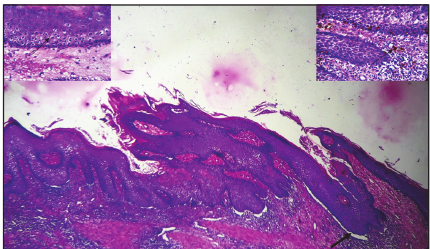
Figure 4: Photomicrograph showing parakeratinised stratified squamous epithelium with bulbous rete ridges lining the cystic lumen. Spinous and superficial cells exhibiting koilocytic changes (leftinset);basalandsuprabasalcellsshowingmelaninpigmentation (right inset) (10x, H &